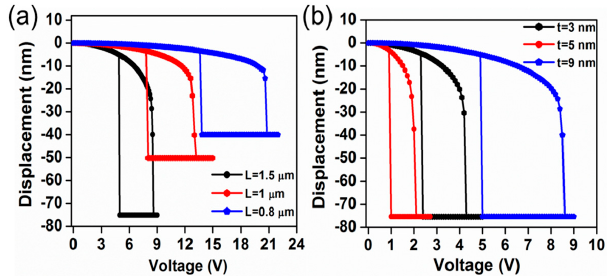
Figure 3. Pull-in and pull-out switching characteristics of the double-clamped graphene beam NEM switches. ( a ) Switching characteristics of graphene beam NEM switches A, B, and C; ( b ) Switching characteristics of graphene beam NEM switch A, with different graphene thicknesses of t = 3, 5, and 9 nm.